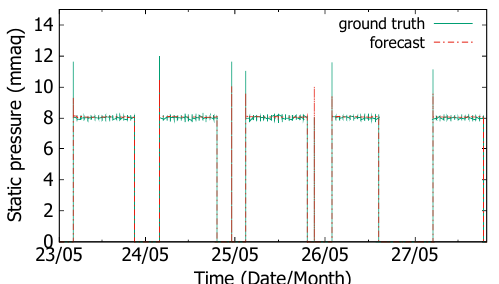
Figure 16. The LSTM-based predictor even catches the momentary spikes at the start of fan